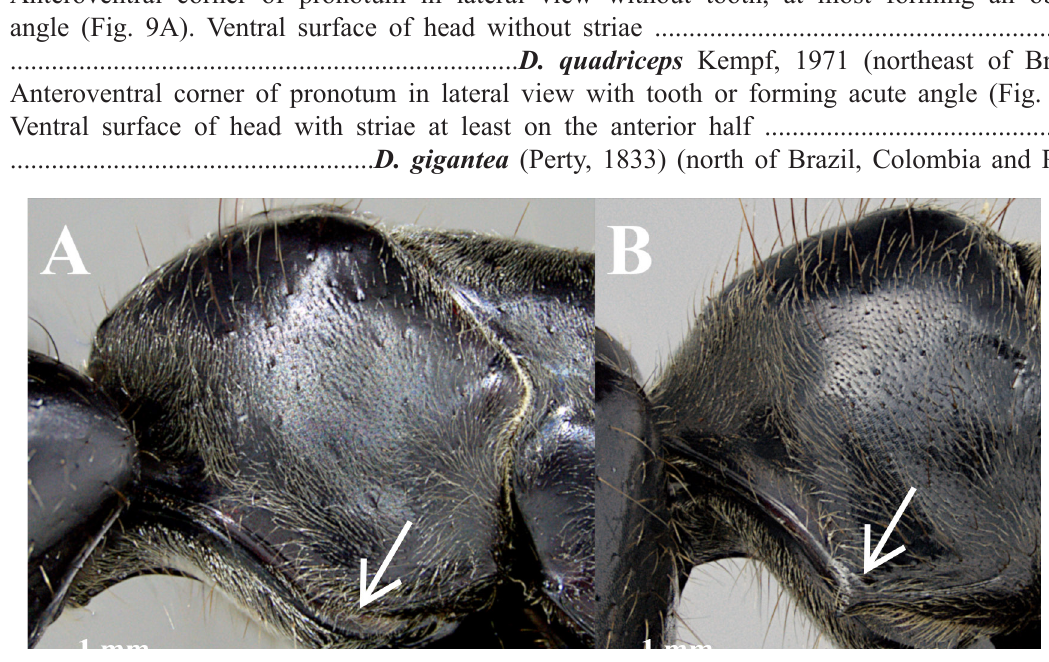
Fig. 9. Anteroventral corner of pronotum in lateral view. A . Dinoponera quadriceps Kempf, 1971. B . D . gigantea (Perty, 1833).